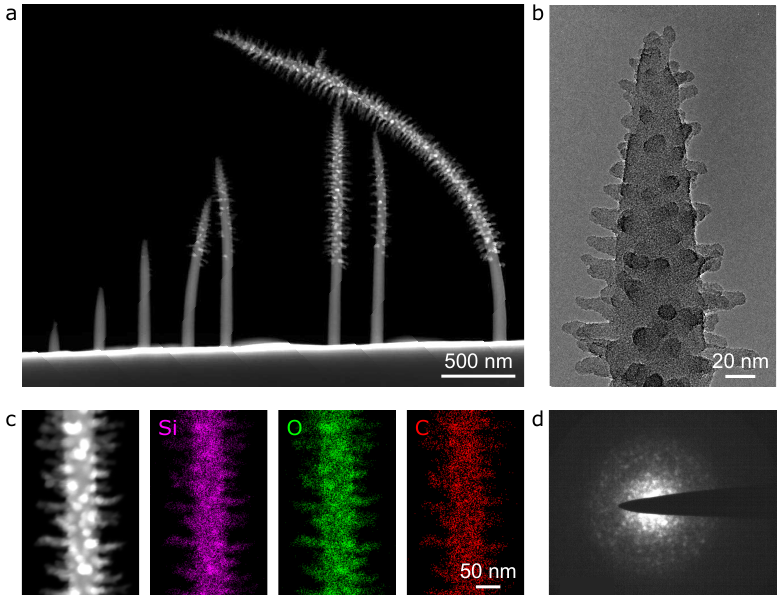
Figure 2. Insulator deposition of nanopillars by helium FIBID (chamber pressure 2 × 10 − 6 Torr, beam current 2.5pA, copper substrate): ( a ) Dark-field STEM of a series of nanopillars (deposition times from left to right: 2, 4, 6, 8, 10, 12, 12 (repeat), and 16s). ( b ) Bright-field TEM of the apex region of the 5th nanopillar in ( a ) (deposition time 10s). ( c ) STEM-XEDS of branched trunk region of the 6th nanopillar in ( a ) (deposition time 12s), showing the reference dark-field STEM image on the left and colorized maps for silicon, oxygen and carbon. ( d ) Selected area electron diffraction pattern for a single